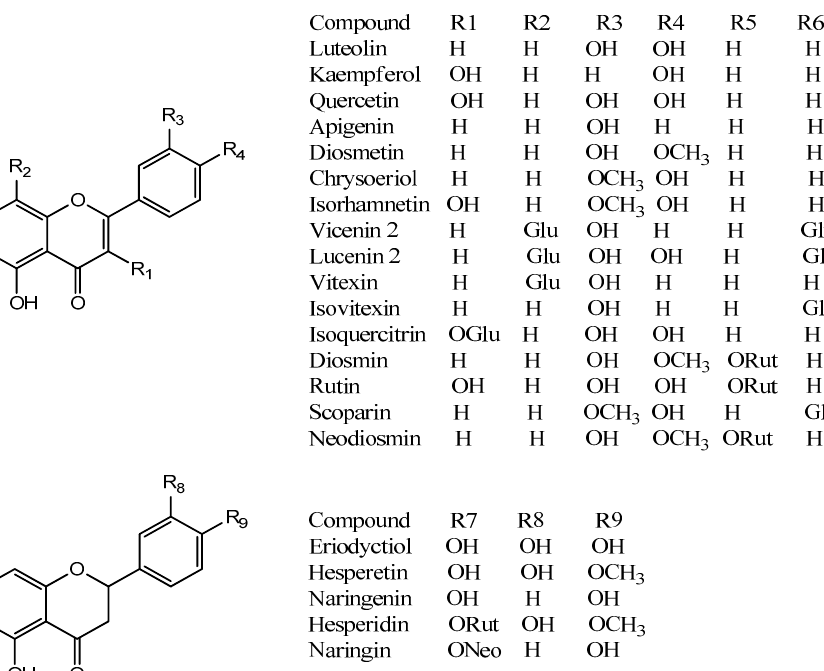
Figure 4. Structures of main flavonoids identified in Citrus species from Northern